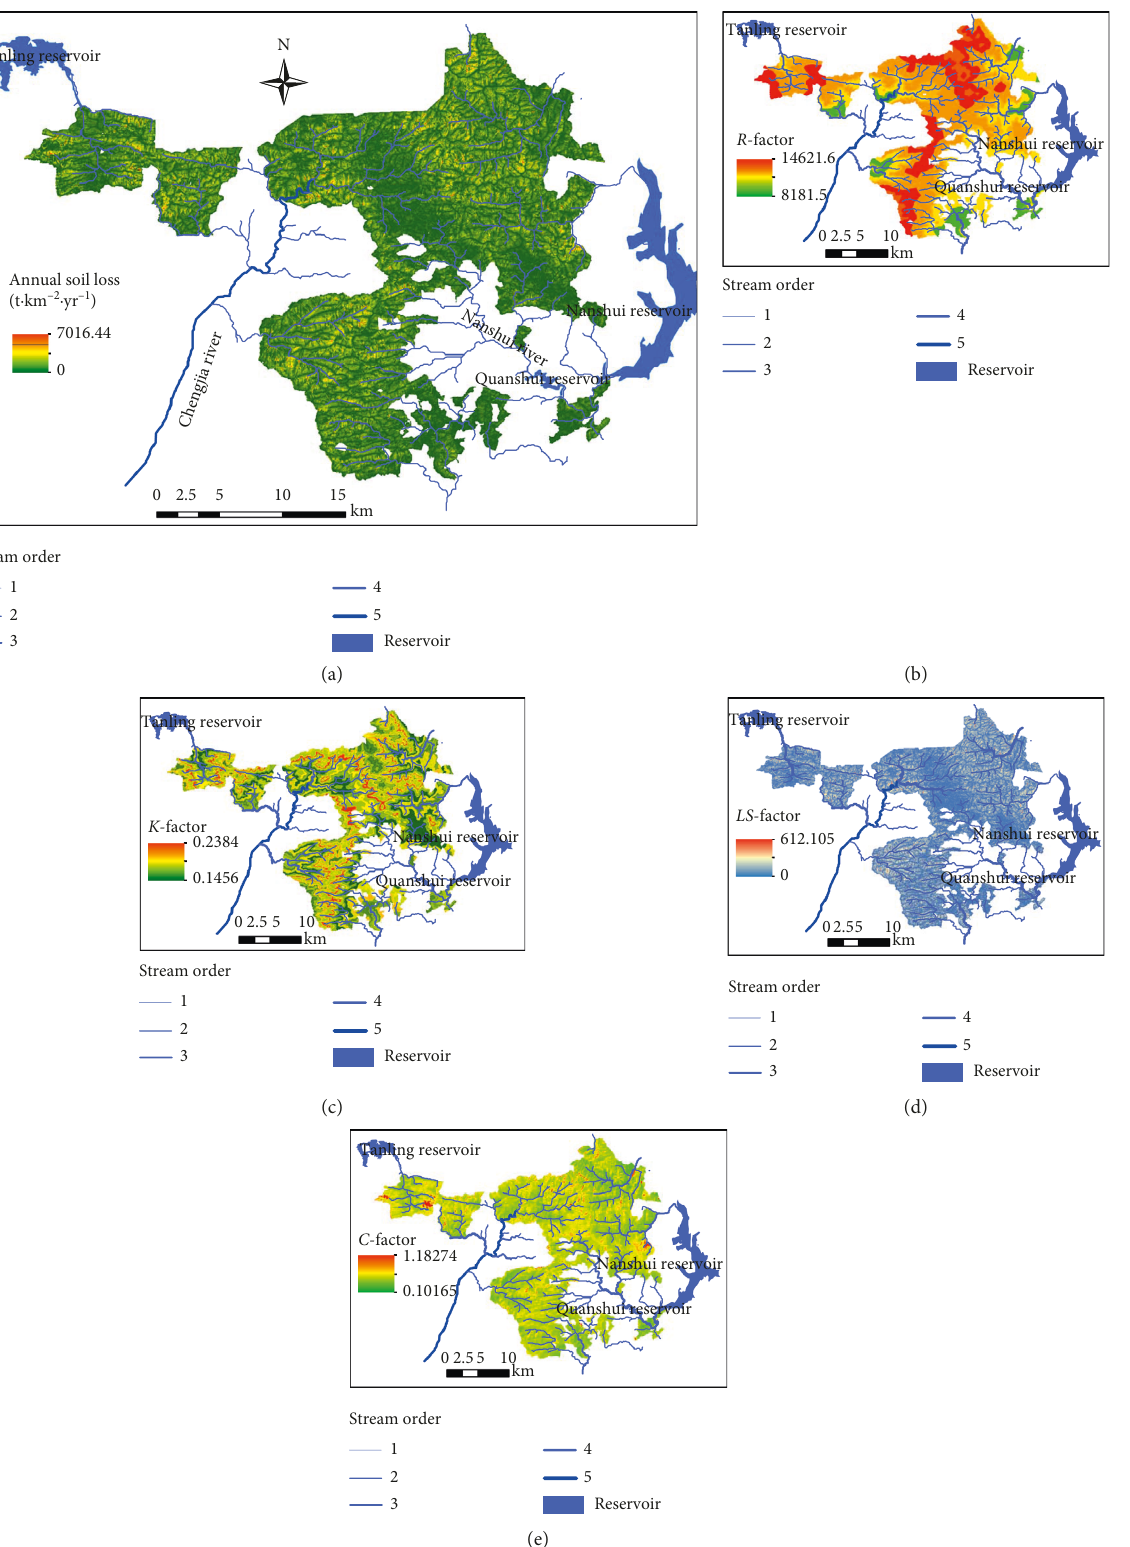
Figure 5: The calculated results of the RUSLE model and its input variables: (a) the calculated result of RUSLE, (b) R -factor, (c) K -factor, (d) LS -factor, and (e) C